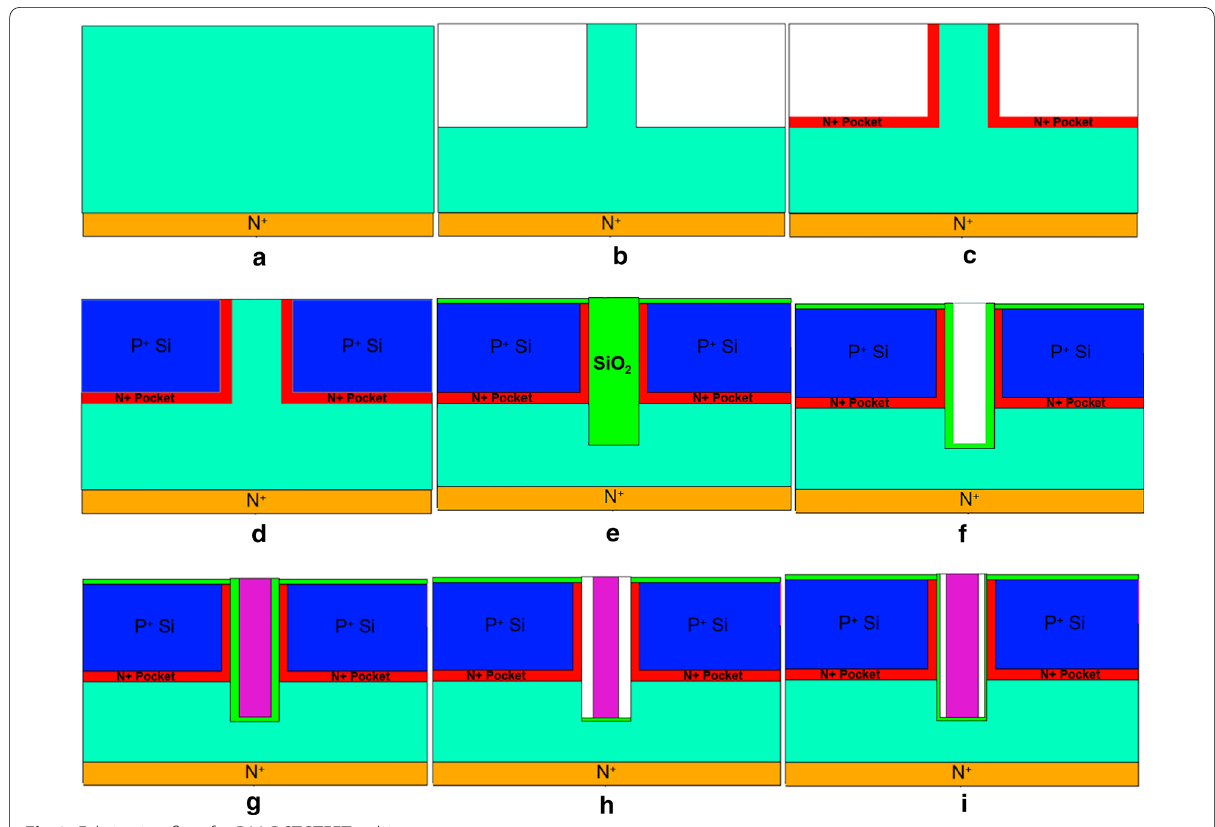
Fig.2 Fabrication flow for DM-DSTGTFET as